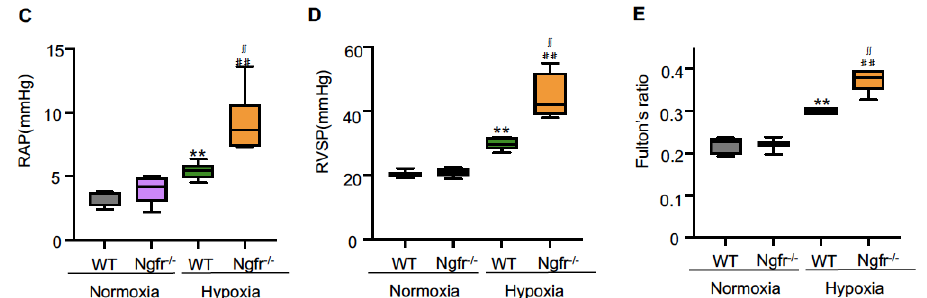
Figure 2. Hemodynamic parameters (RAP and RVSP) in WT and Ngfr − / − mice under normoxic and hypoxic conditions. ( A ) The waveforms of RAP in WT and Ngfr − / − mice under normoxic and hypoxic conditions. ( B ) The waveforms of RVSP in WT and Ngfr − / − mice under normoxic and hypoxic conditions. ( C ) RAP of WT and Ngfr − / − mice under normoxic and hypoxic conditions. ( D ) RVSP of WT and Ngfr − / − mice under normoxic and hypoxic conditions. ( E ) Fulton’s ratio (RV/LV+S) of WT and Ngfr − / − mice under normoxic and hypoxic conditions. RAP, right atrial pressure; RVSP, right ventricular systolic pressure; RV, right ventricle; LV, left ventricle; S, septum. Center lines show the medians, box limits indicate the 25th and 75th percentiles, whiskers extend 1.5 × the interquartile range from the 25th and 75th percentiles. ** p < 0.01 versus WT Normoxia. ## p < 0.01 versus Ngfr − / − Normoxia. (cid:82) (cid:82) p < 0.01 versus WT Hypoxia.